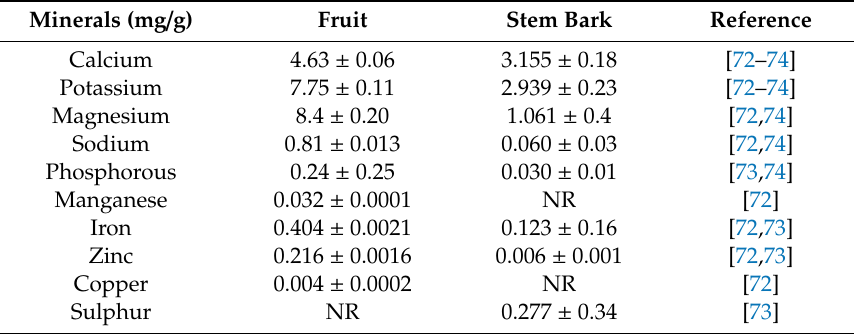
Table 4. Mineral analyses of M. esculenta fruits and stem bark.